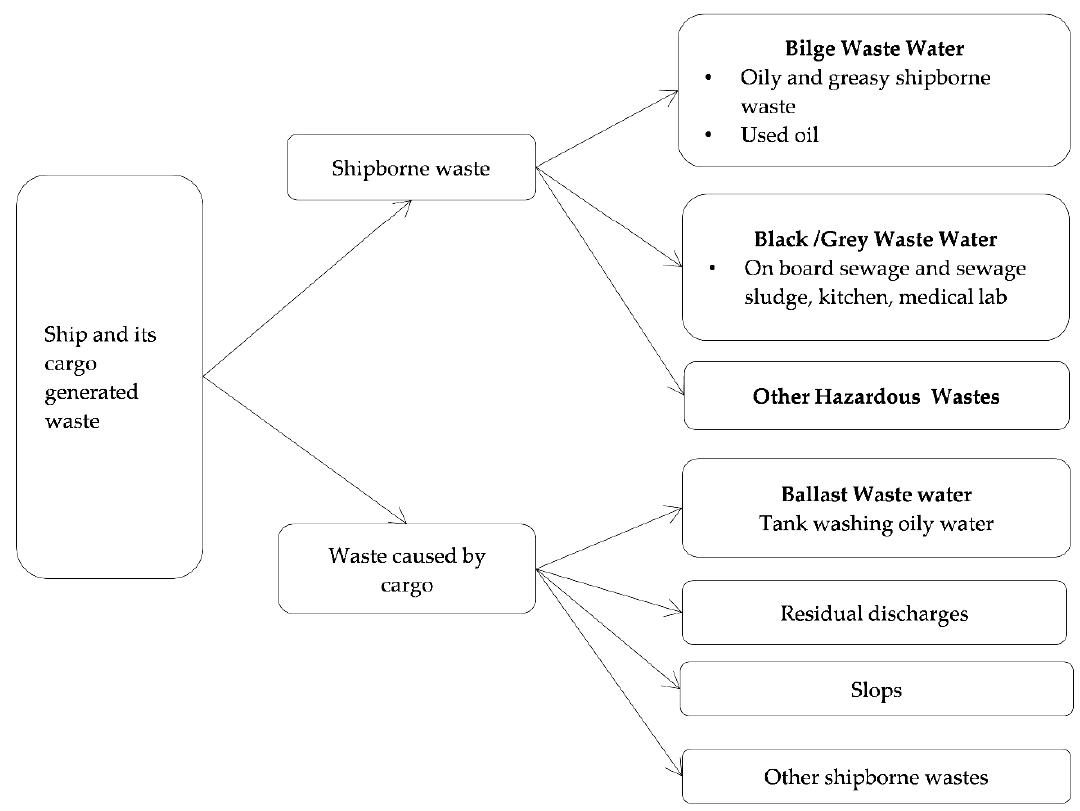
Figure 1. Classification of ship and cargo generated waste discharged in and out of the port environment. Source: adapted from ([12], cited by [13]).